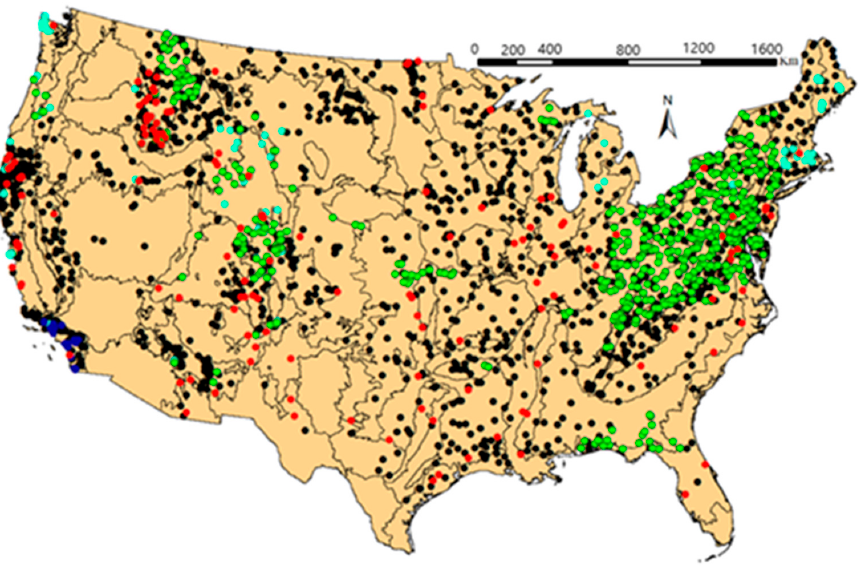
Figure 3. Distribution of D50 data points over Level III Ecoregions. Dots with different colors in the figure represent different D50 data sources.